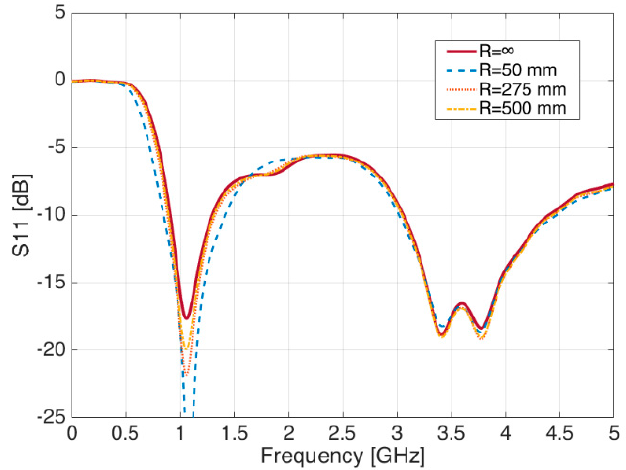
Figure 7. Reflection coefficient S 11 for different values of ‘R’—Bending in the ‘X’ direction.